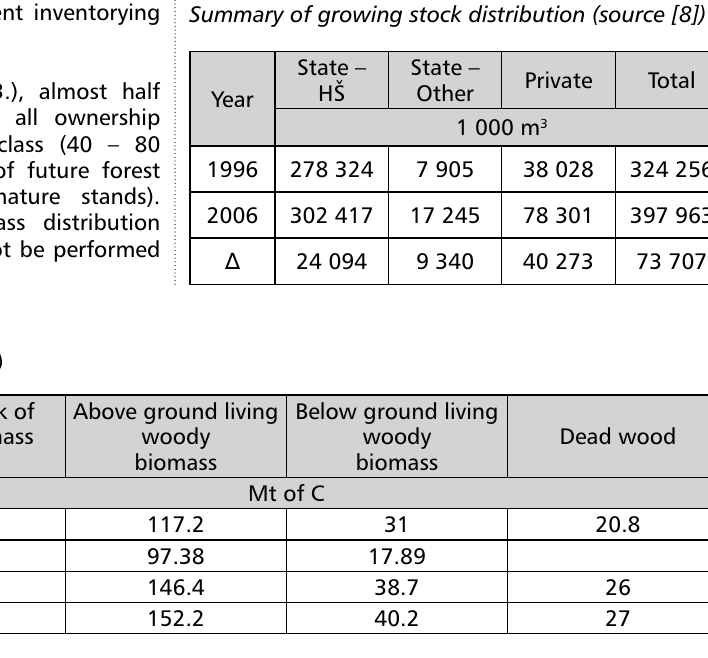
the line with increase in forest area and growing stock, there is also an increase in carbon stock (1.4.) of forests (Table